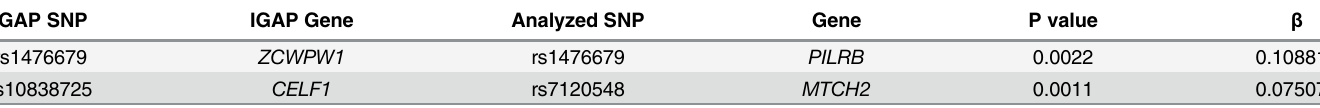
Table 5. eQTLs of IGAP GWAS SNPs in GSE15222. IGAP